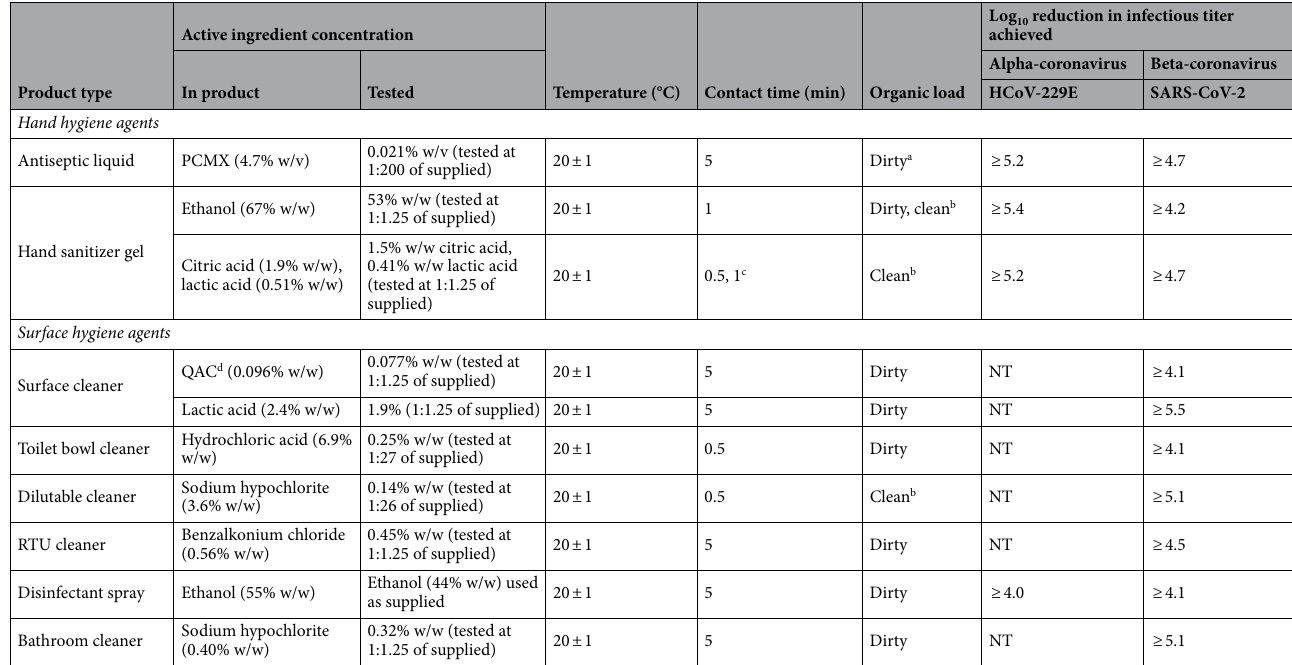
Table 5. Virucidal efficacy of formulated microbicidal actives tested per EN 14,476:2013 + A2:2019 Standard against HCoV-229E or SARS-CoV-2 in suspension inactivation studies. In all cases, one technical replicate was performed per data point. Abbreviations used: BSA, bovine serum albumin; HCoV-229E, human coronavirus strain 229E; NT, not tested; PCMX, p -chloro- m -xylenol; RTU, ready to use; SARS-CoV-2, severe acute respiratory syndrome coronavirus 2, w/v, weight-to-volume, w/w, weight-to-weight. a Dirty means 3 g/L contact time was used for testing against HCoV-229E; an 0.5-min contact time was used for testing against SARS-CoV-2. d Alkyl dimethyl benzyl ammonium chloride